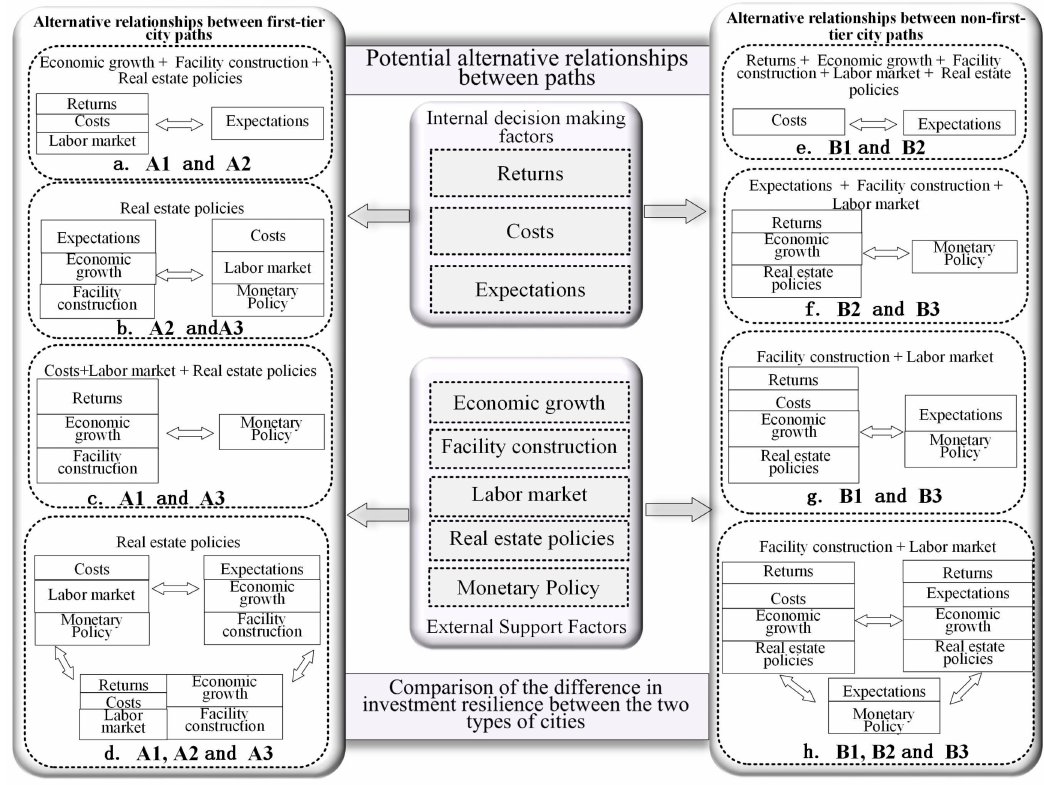
Figure 6. Substitutions between paths for first-tier and non-first-tier